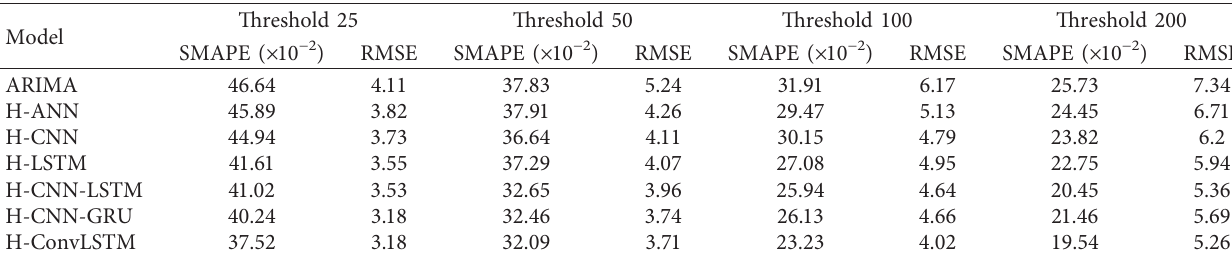
Table 3: Comparison of different models in minimum demand threshold type